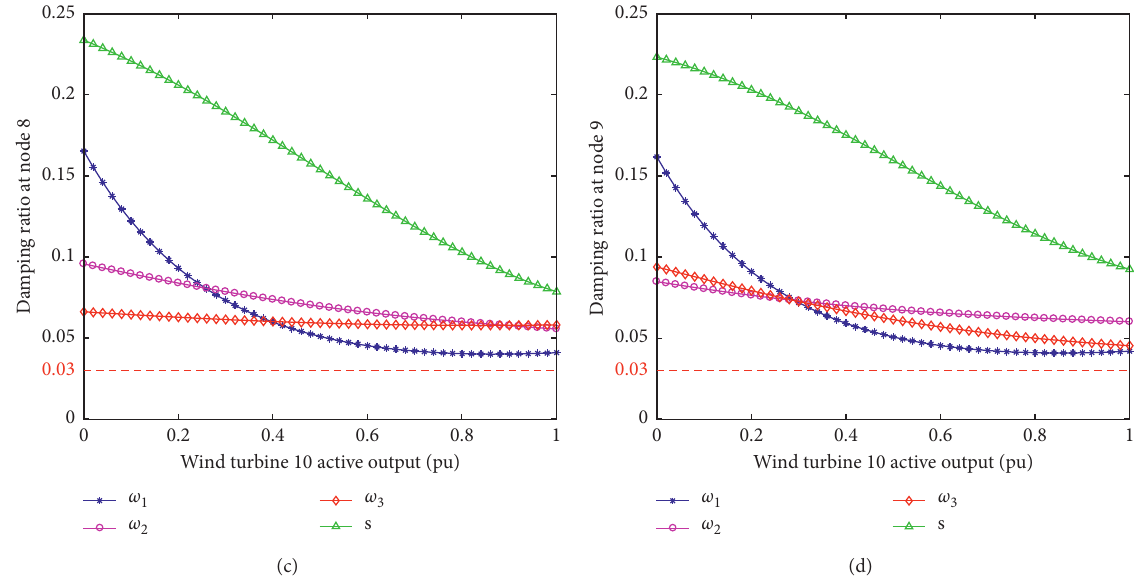
Figure 7: Curve of damping ratio change after the PSS is added into generator